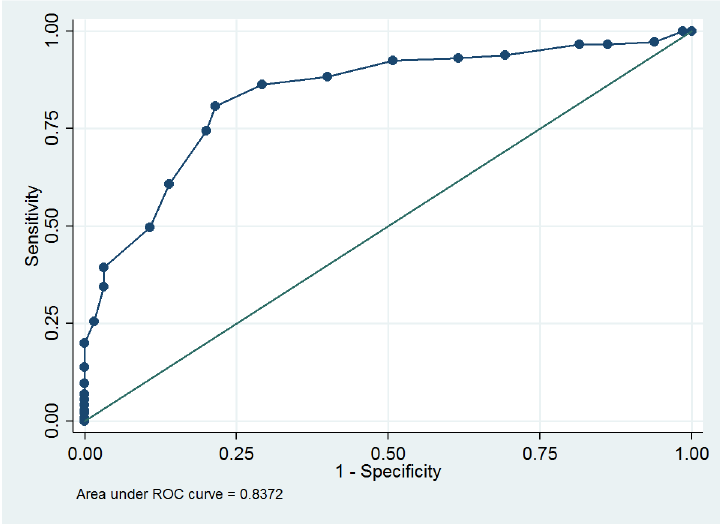
Fig 3. ROC curve for those with mild ENL and those with either moderate or